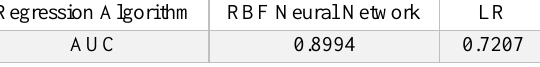
Table 3. Comparison of the Area Under the ROC Curve in the various interpolation methods